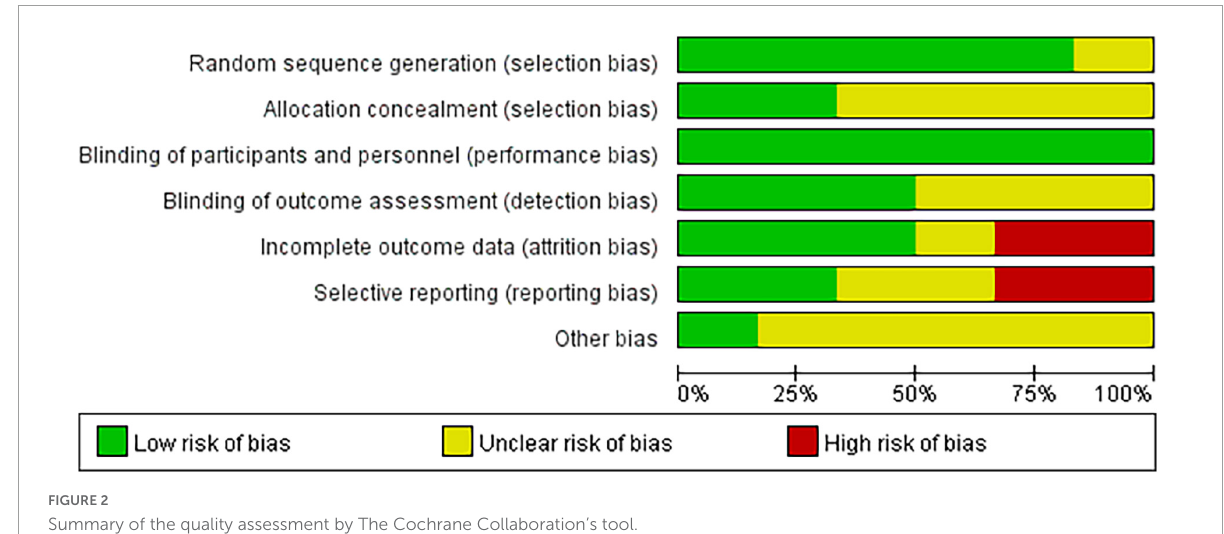
FIGURE2 Summary of the quality assessment by The Cochrane Collaboration’s tool.